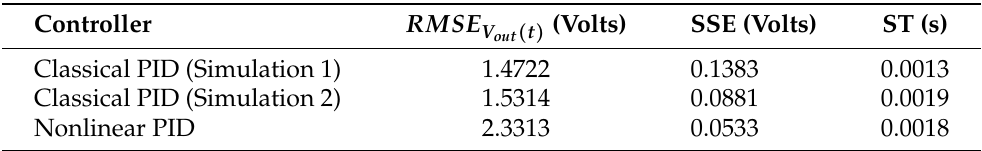
Table 4. System performance for scenario